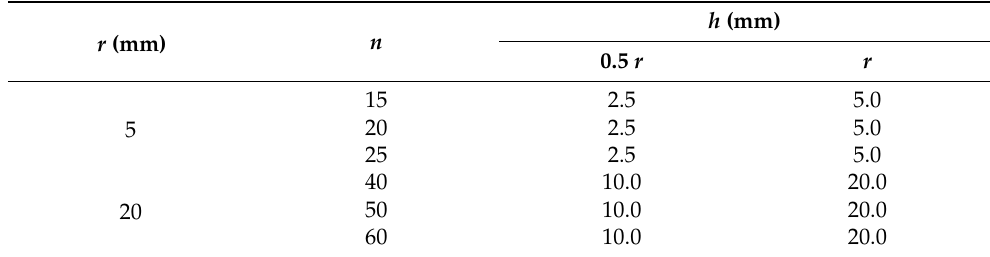
Table 2. Variants of geometric parameters taken for the analysis of two types of